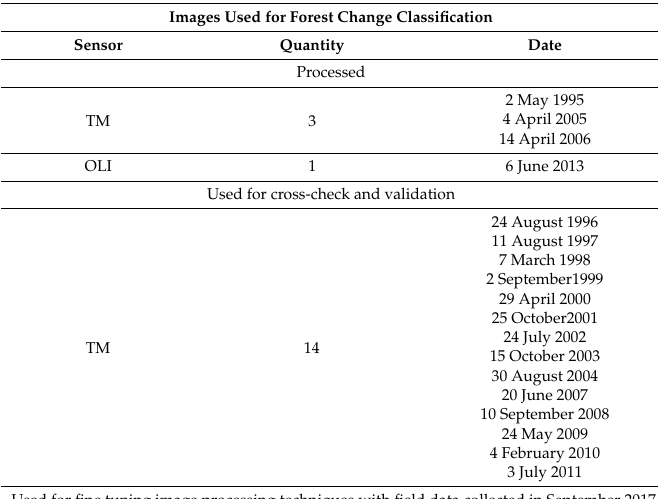
Table 1. Landsat images used in the